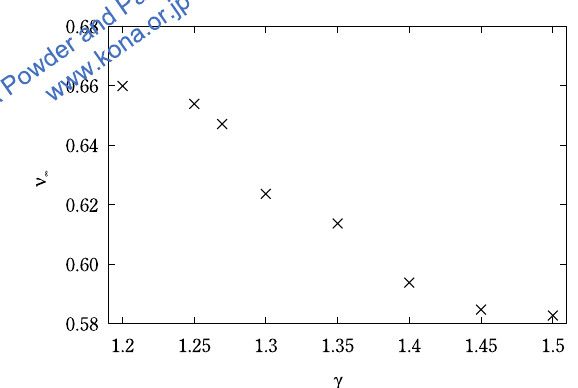
Fig. 11 Mean coordination number 〈 N C 〉 versus ν ∞ from the simula- tion results ( ▲ ) and experimental measurements ( ♢ ) of Aste et al. [53]. This comparison with the experimental data shows good agreement.